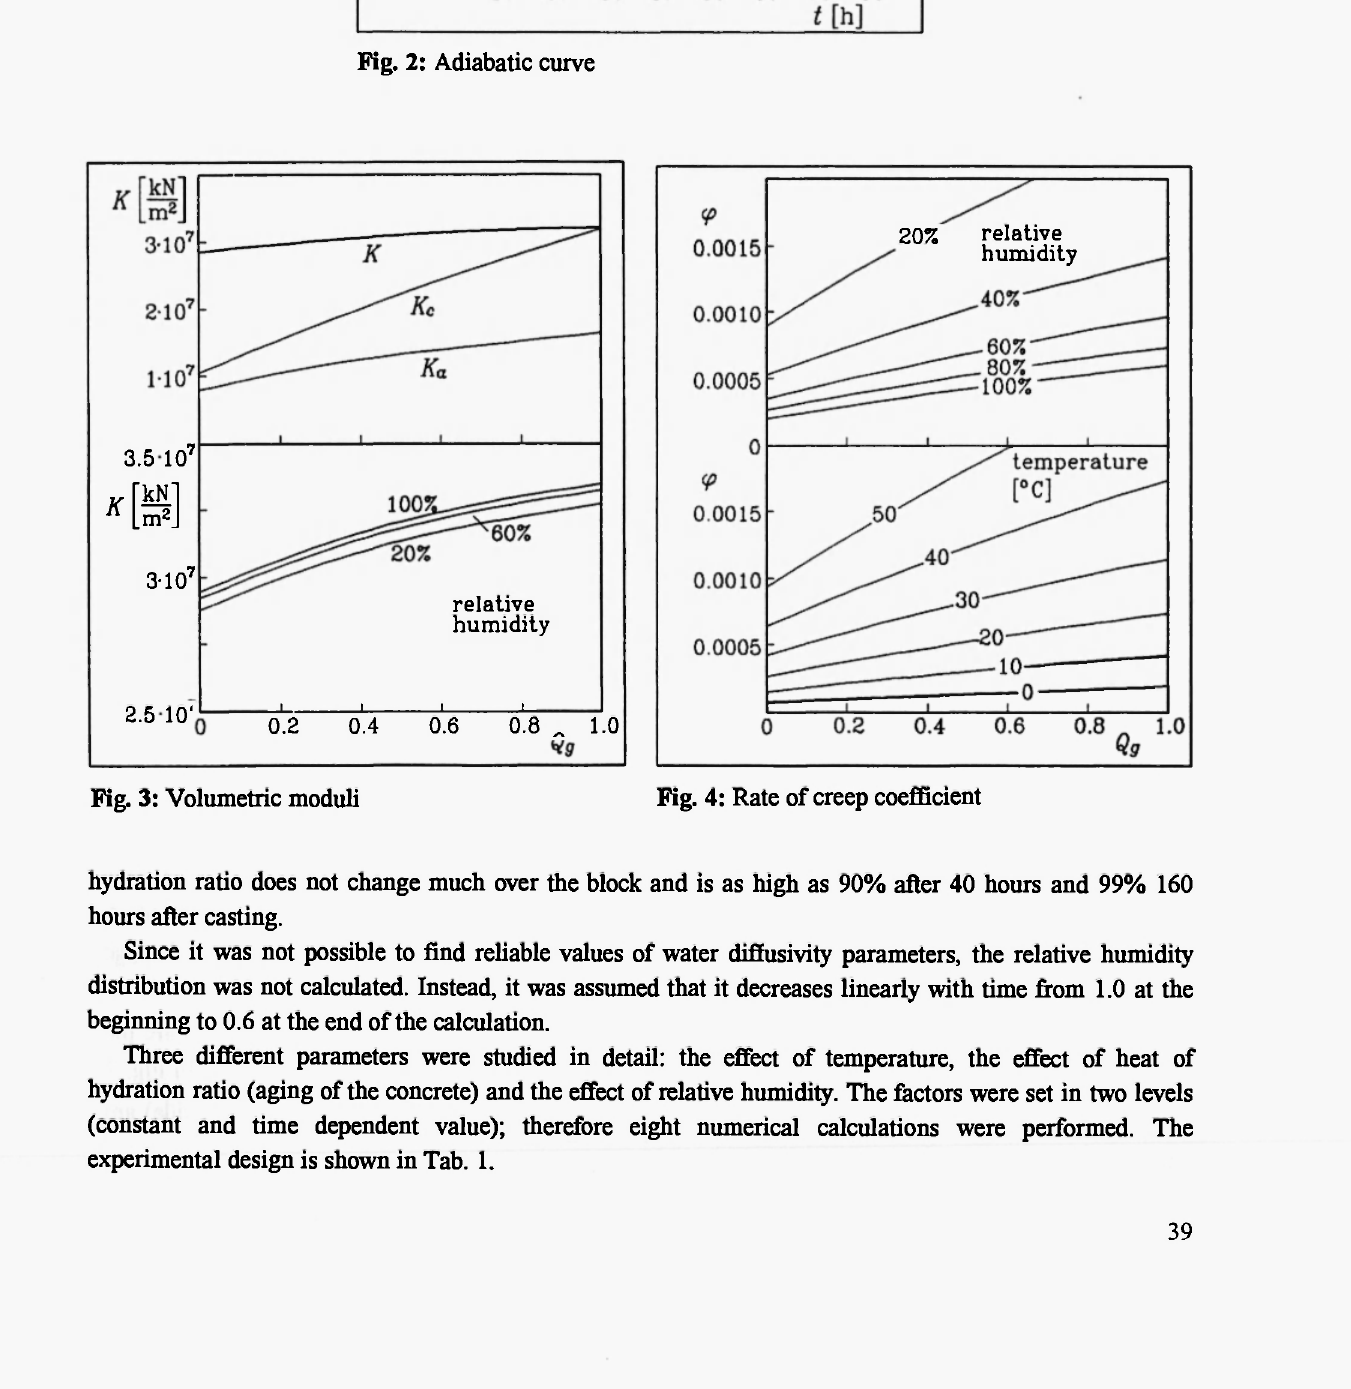
Fig. 2: Adiabatic curve